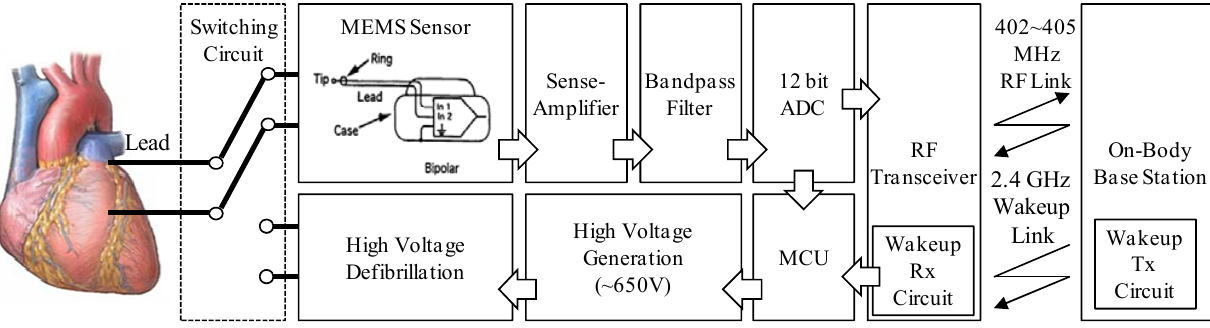
Figure 7. Structure of the ICD